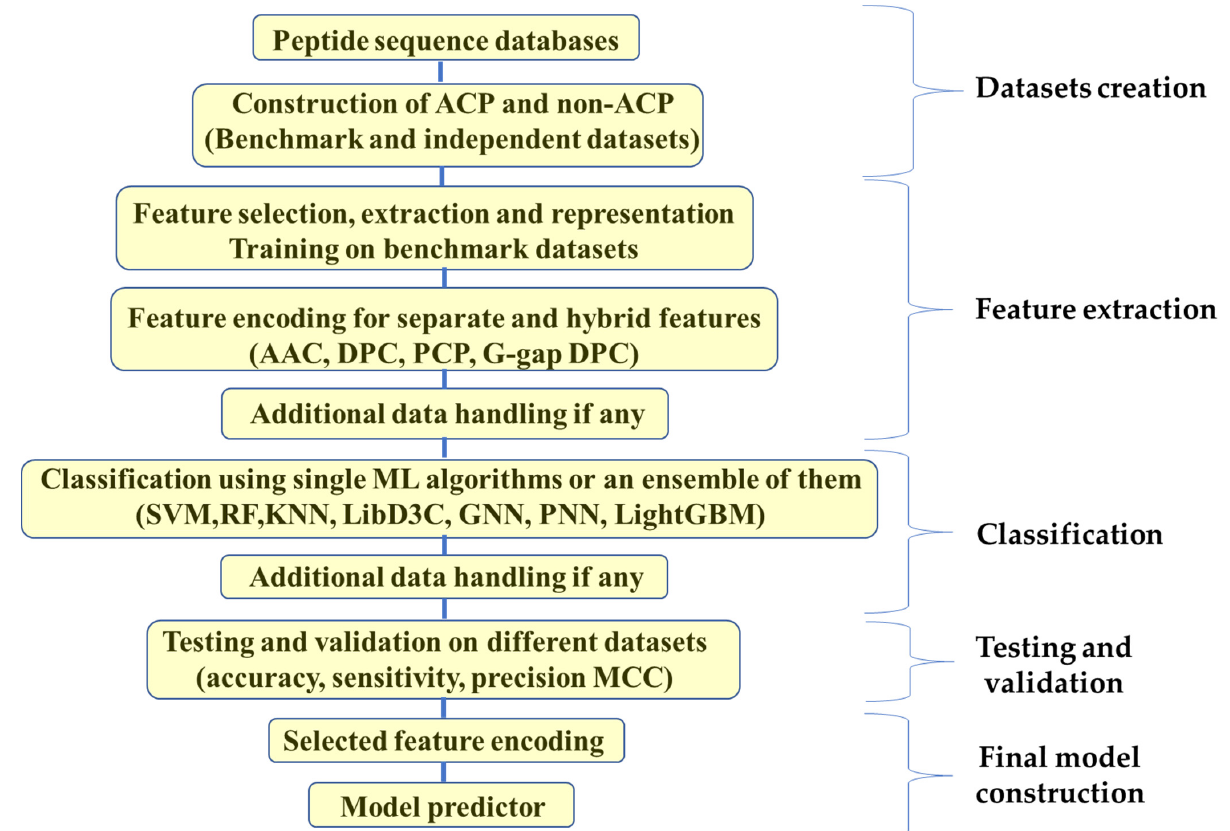
Figure 3. Schematic representation showing different steps of traditional machine learning approach for building a predictor for ACPs.